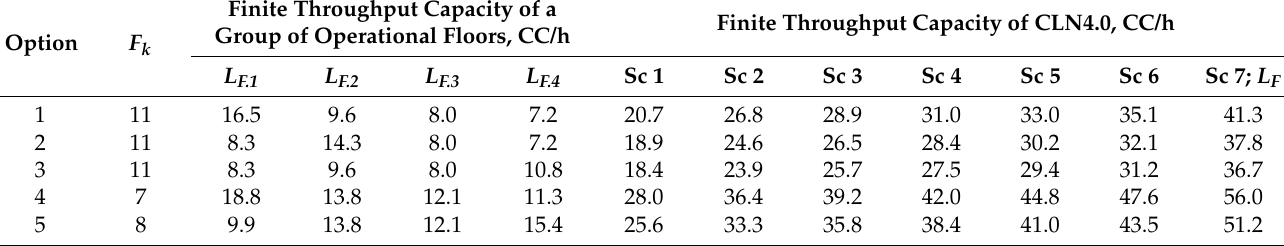
Table 3. The finite throughput capacity of groups of operational floors and total finite throughput capacity of CLNs4.0. Finite Throughput Capacity of a Group of Operational Floors, Option F k